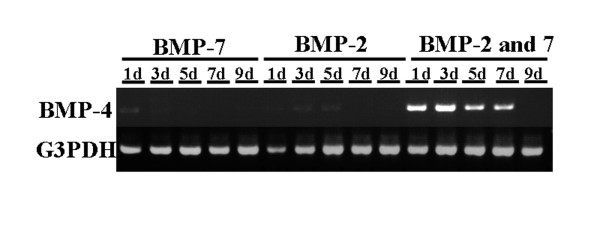
Rat BMP-4 expression after gene transfer with BMP-2, BMP-7, or BMP-2 and BMP-7. Rat BMP-4 mRNA expression in muscles electroporated with pCAGGS-BMP-2, pCAGGS-BMP-7, or pCAGGS-BMP-2 and pCAGGS-BMP-7 detected by RT-PCR. The BMP-4 mRNA was highly expressed in the muscles that received the combined BMP-2 and BMP-7 gene transfer.